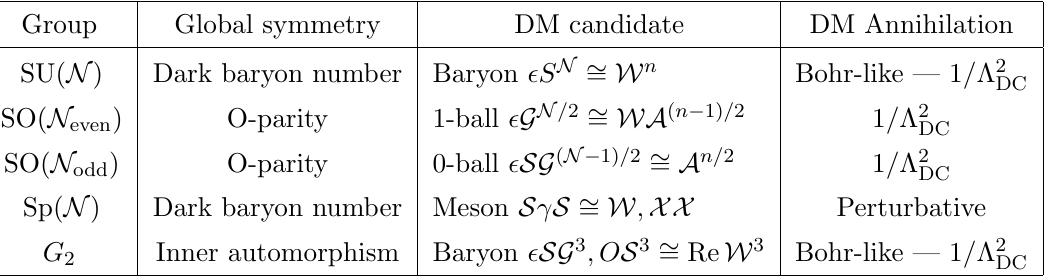
Table 2 . Dark matter candidates, thier stabilizing symmetries, and dominant annihilation mech- anisms in the various